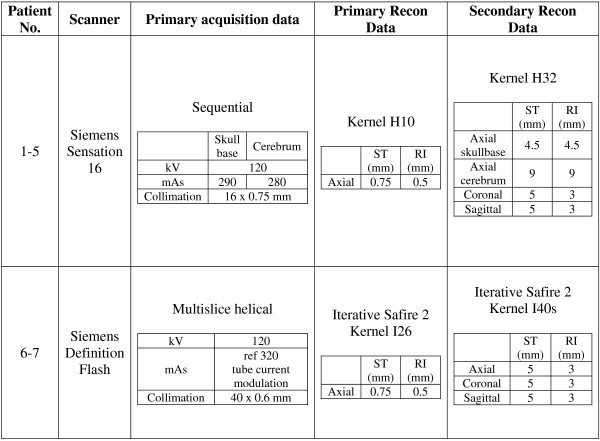
Physical acquisition parameters of CT scanner.